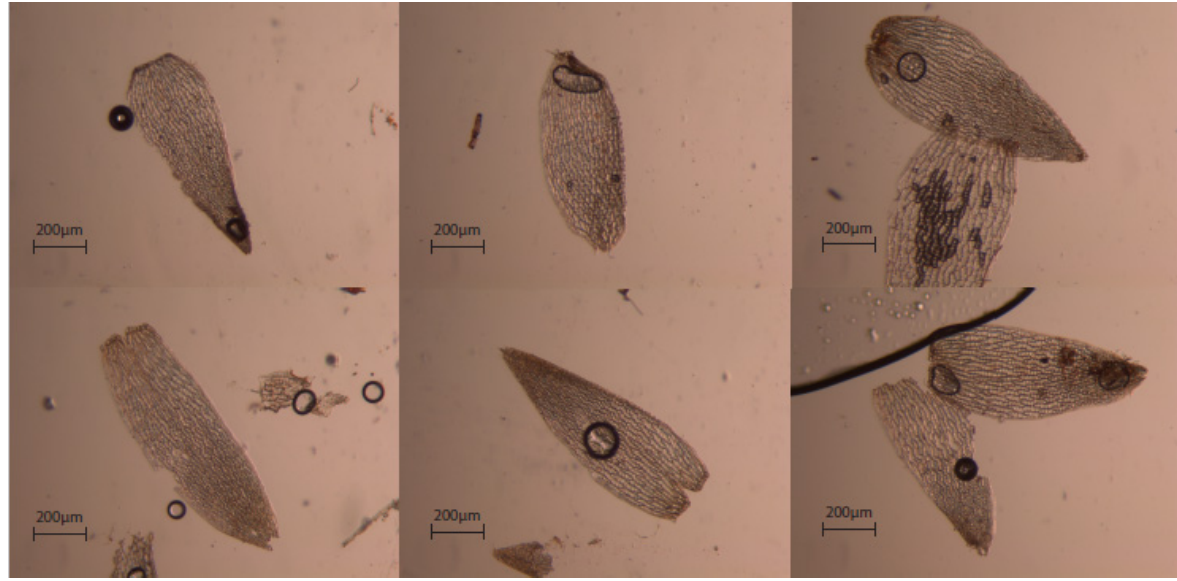
Figure 7. Sample leaf morphologies used for modern species identification (Hill, 2016). The top left panel is S. fuscum , top middle is S. capillifolium , top right is S. rubellum , bottom left is likely S. balticum, bottom middle is S. fallax and bottom right is S. pulchrum .